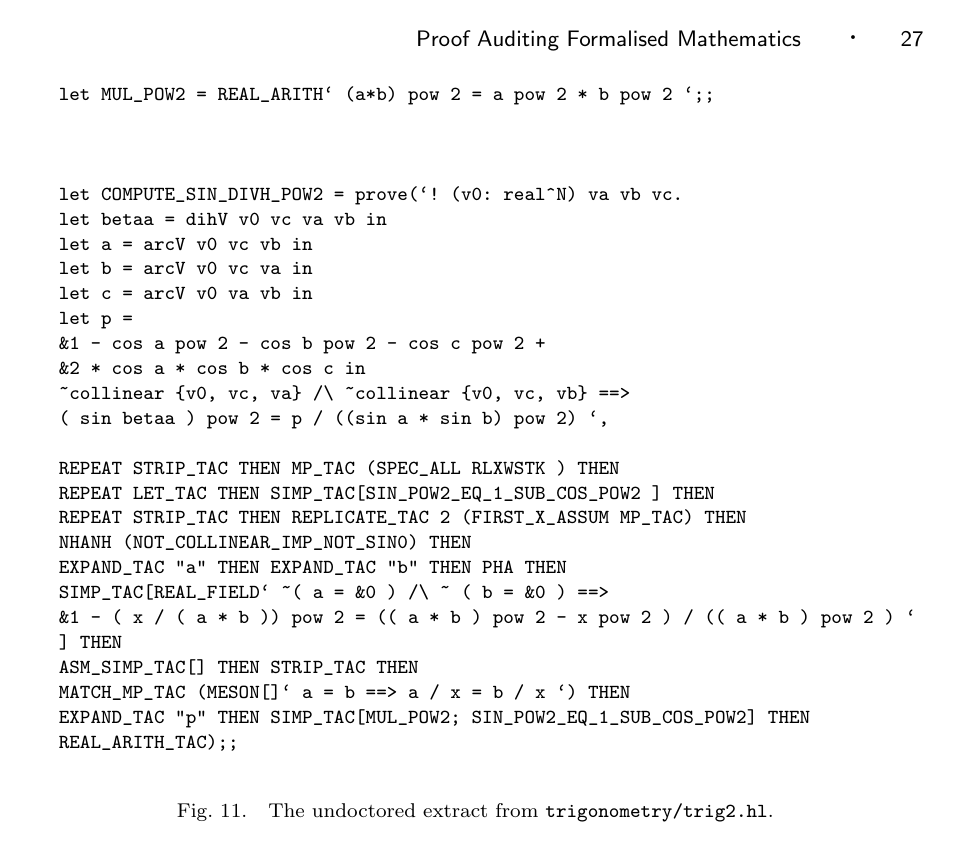
Fig. 11. The undoctored extract from trigonometry/trig2.hl .